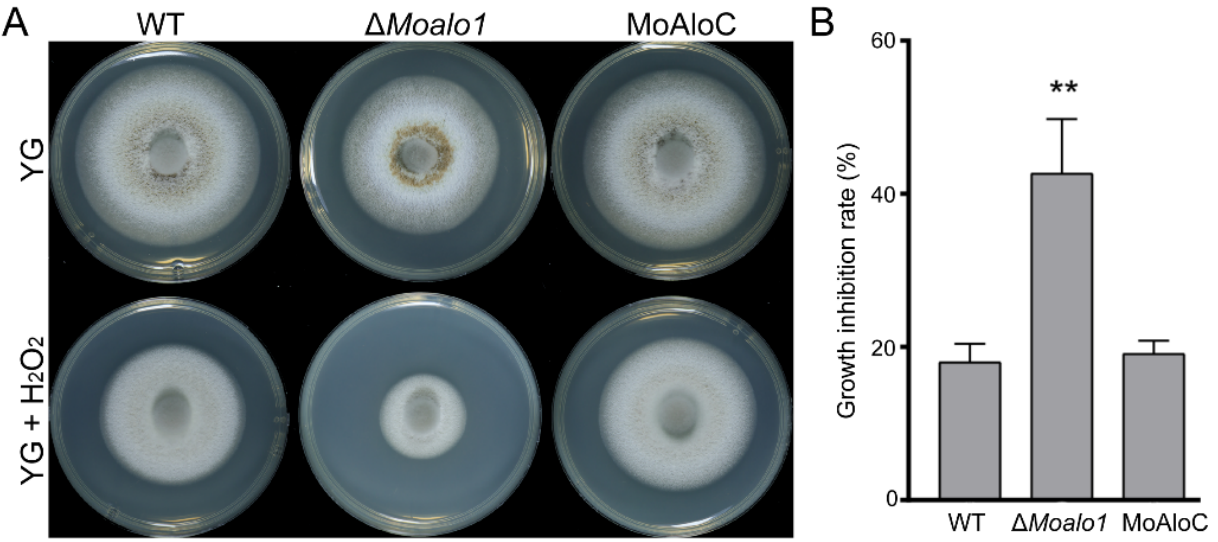
Figure 3. MoAlo1 plays a role in oxidative stress. ( A ) Colony morphology of Guy11, ∆ Moalo1 , and the complementary strain MoAlo1C. Strains were cultured on YG and YG plates supplemented with H 2 O 2 (10 mM), then cultured at 25 °C for 8 days before photography. ( B ) The growth inhibition rate of the strains. Prism 7.0 software was used to analyze the data. Asterisks indicate statistically significant differences ( t test, ** p < 0.01).